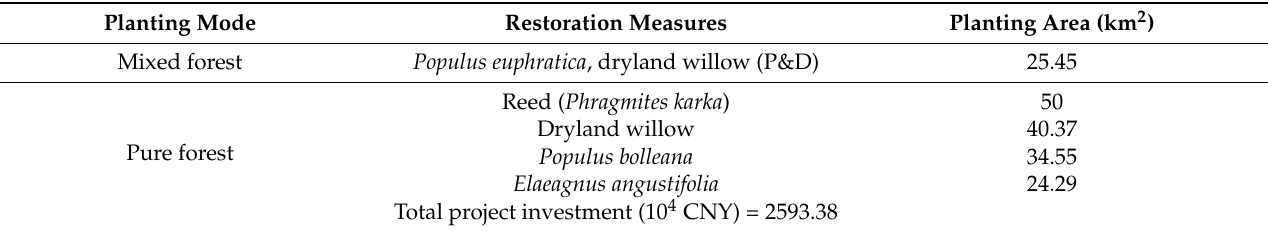
Table 3. The original scheme of the wetland restoration